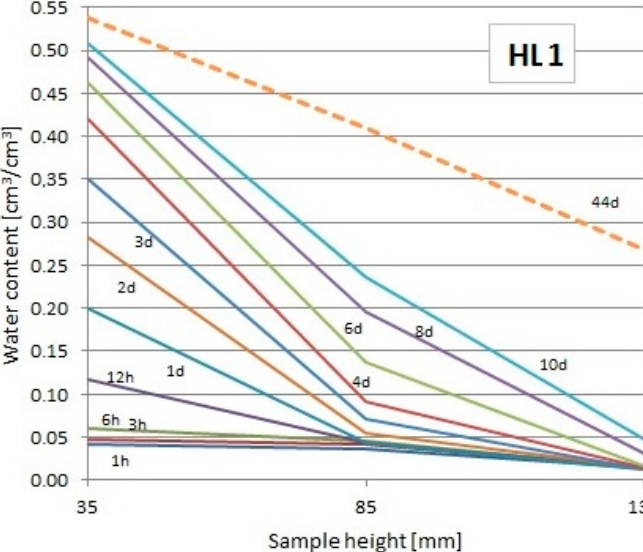
Figure 10. Moisture profiles obtained using the TDR measurement in particular intervals for the HL1 composite.